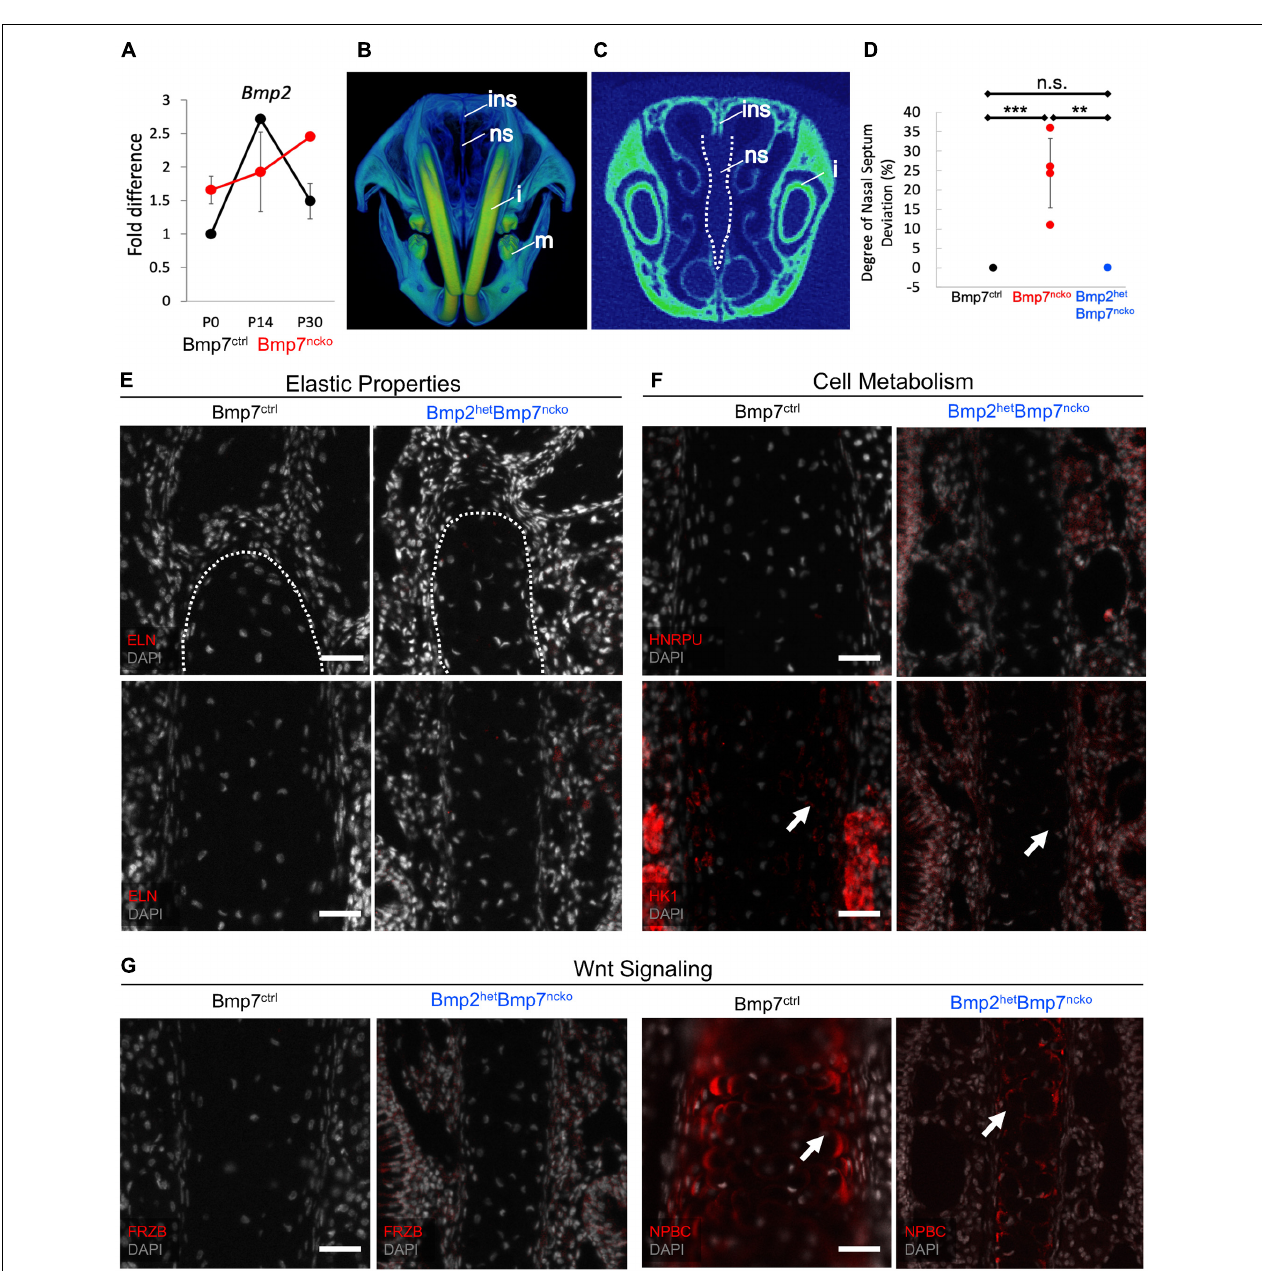
FIGURE 8 | Reduction of BMP2 in Bmp7 ncko mice rescues the nasal septum deviation. (A) qRT-PCR of P0, P14, P30 dissected nasal septum revealed an increase in BMP2 expression at P30 in Bmp7 ncko mice. (B) 3D frontal view of P30 Bmp2 het Bmp7 ncko mouse demonstrating a straight nasal septum. (C) 2D overview of nasal septum (outlined in white). (D) Quantification of nasal septum deviation in Bmp2 het Bmp7 ncko mice revealed no significant difference between Bmp7 ctrl and Bmp2 het Bmp7 ncko . Note that the data for Bmp7 ctrl and Bmp7 ncko is repeated from Figure 1L . (E) No expression of Elastin (ELN) was observed in P30 Bmp2 het Bmp7 ncko mouse. (F) Immunofluorescence staining of Heterogeneous nuclear ribonucleoprotein U (HNRPU) in P30 Bmp7 ctrl and Bmp2 het Bmp7 ncko mice was comparable, however, staining with Hexokinase (HK1) showed a reduction in expression of HK1 in the Bmp2 het Bmp7 ncko mouse. (G) Expression of FRZB between P30 Bmp7 ctrl and Bmp2 het Bmp7 ncko mice was comparable but a slight reduction in Non-Phosphorylated Beta-Catenin (NPBC) was observed in Bmp2 het Bmp7 ncko mice. However, both Bmp7 ctrl and Bmp2 het Bmp7 ncko mice demonstrated cytoplasmic expression of NPBC. Ins, internasal suture; ns, nasal septum; i, incisor; m, mandible. Independent two-tailed t -test was performed with significance denoted as *: P < 0.05, **: P < 0.01, ***: P < 0.001. ( n = 3/genotype/age). Antibody expression demonstrated in red and DAPI stained nuclei in gray for all immunofluorescence images. Arrows denoting positive antibody signal. Scale bar = 50 µ